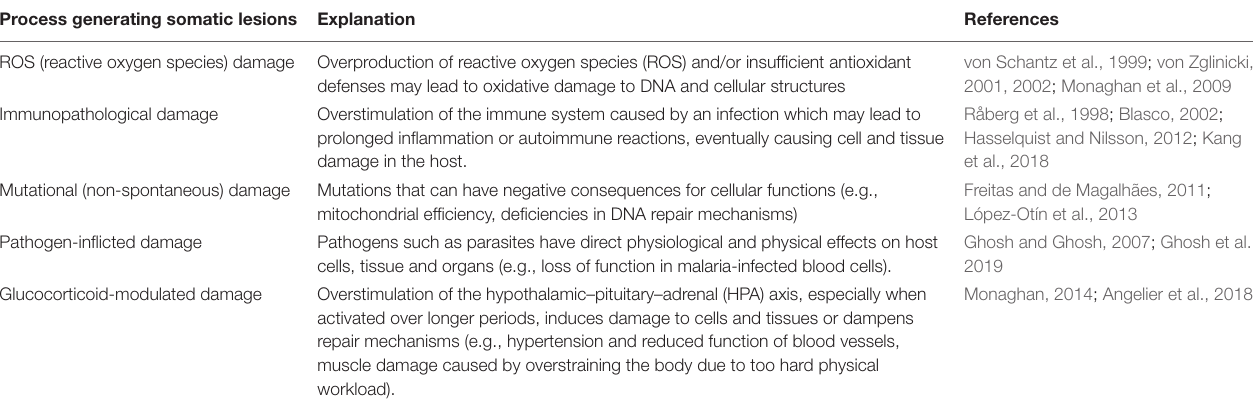
TABLE 1 | Possible cellular processes that could cause the small “somatic lesions” generating small (“hidden”) physiological costs that underlie the cost accumulation process as envisioned in the accumulating costs hypothesis. Process generating somatic lesions